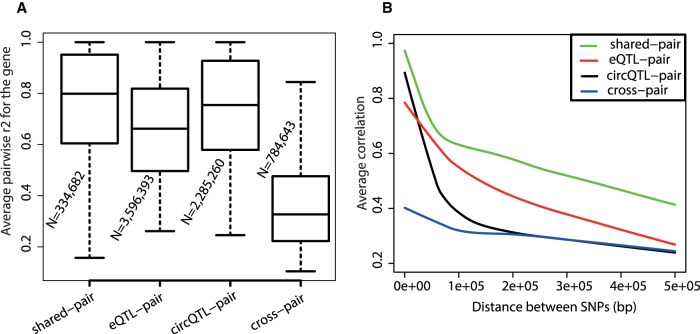
LD structure between circQTL and eQTL markers. (A) Boxplot distributions of the average pairwise correlation (r2) between shared QTL, eQTL, circQTL, and cross-QTL SNPs for each gene. Average pairwise correlations were computed for each category of QTL markers for genes containing both circQTL and eQTL SNPs. Cross-pair is the pairwise correlation between a circQTL and an eQTL marker. For each boxplot distribution, N represents the total number of pairwise combinations from all genes; only combinations with r2 > 0.1 were used for the analysis. (B) LOESS fit curves for average correlation (r2) versus distance between the QTL markers.